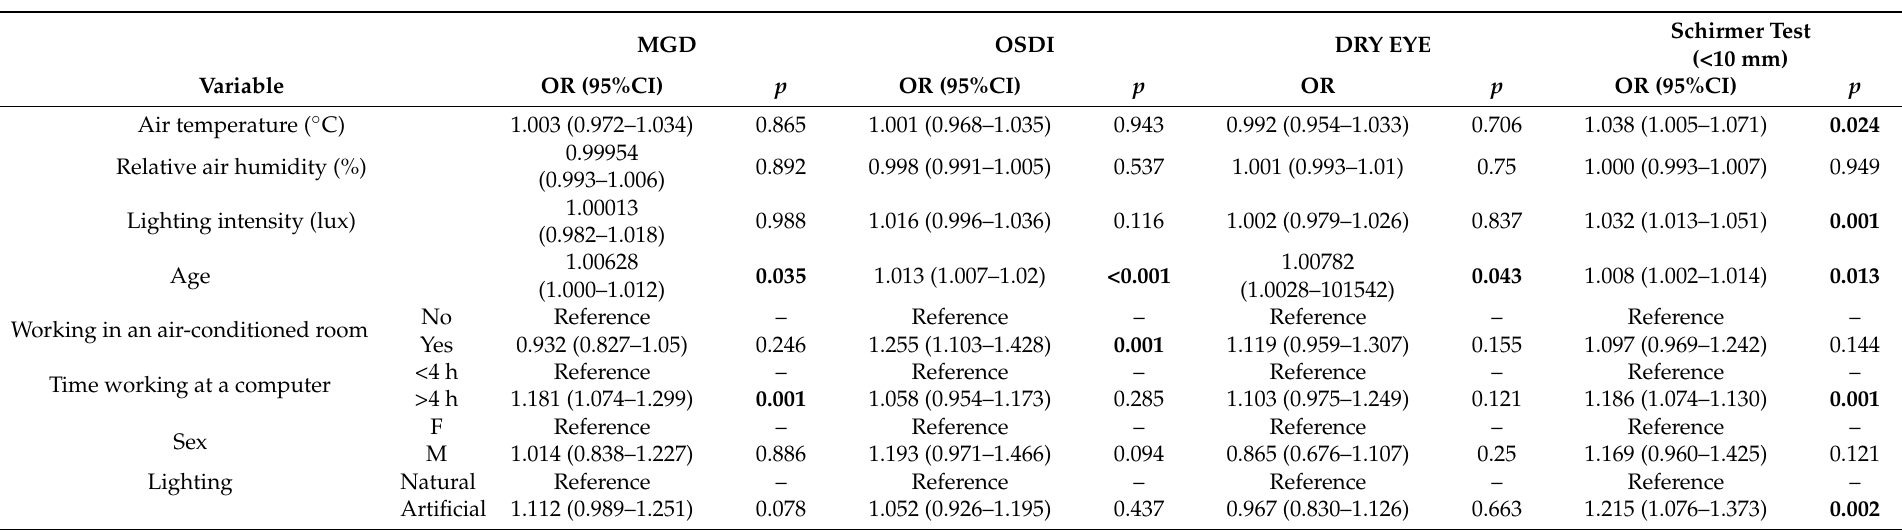
Table 6. Multivariable logistic regression to determine the influence of temperature, relative air humidity, and lighting intensity on the incorrect results of the eye surface